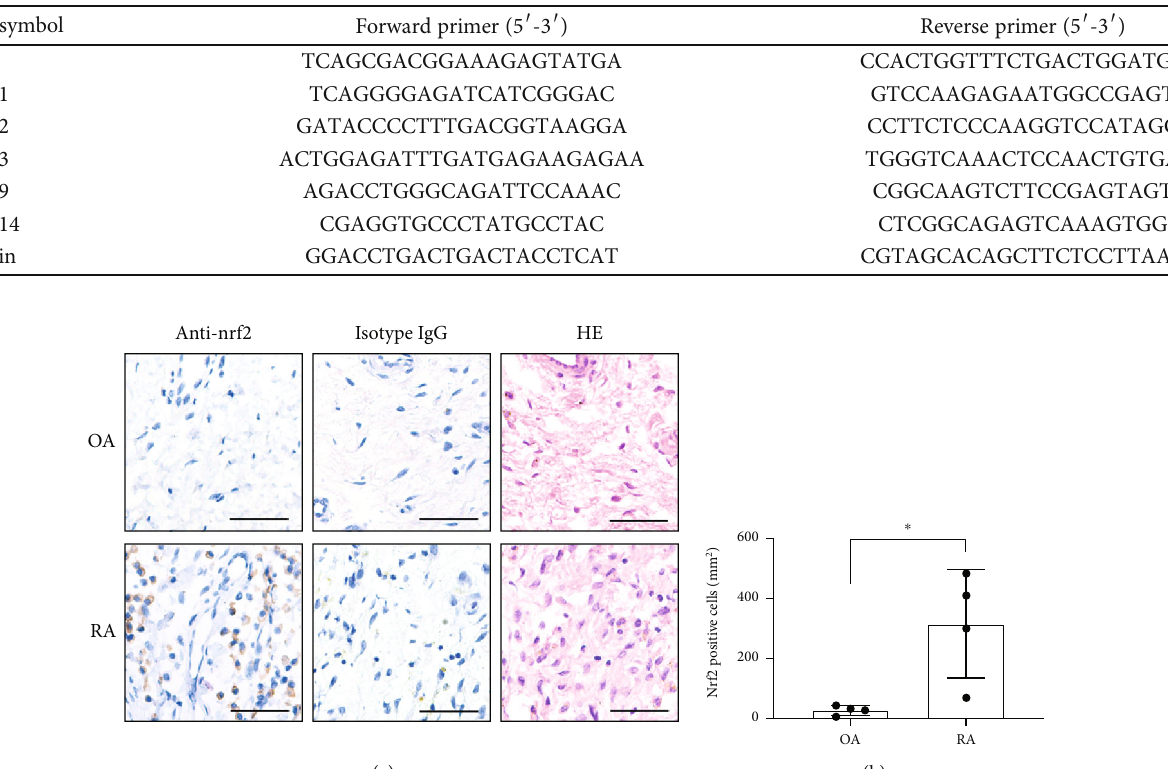
Table 1: Primer sequences for real-time PCR.